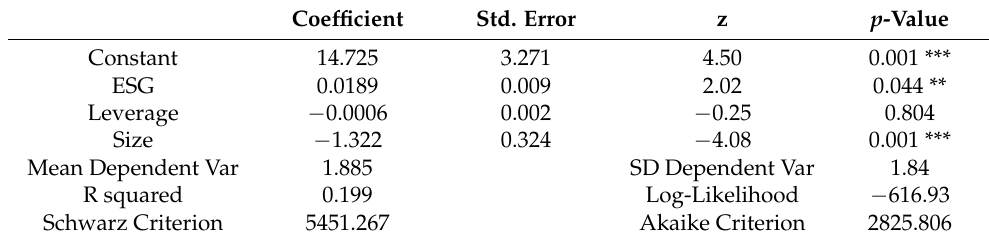
Table 9. Random Effects (GLS), Dependent Variable: Tobin’s